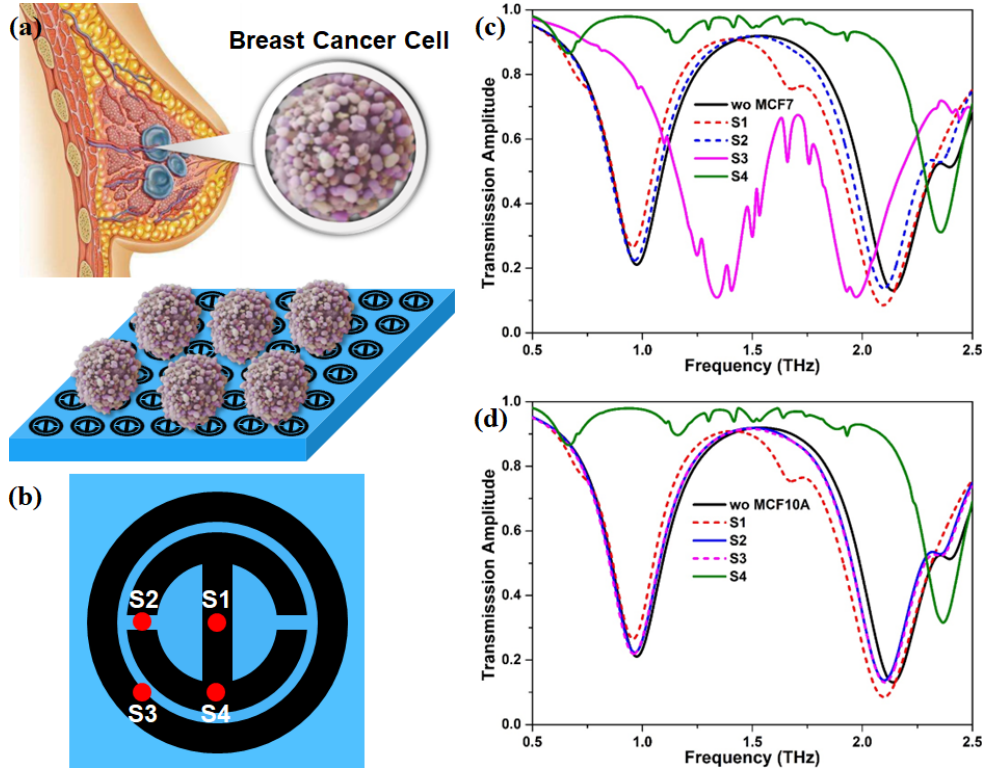
Figure 5. ( a ) The schematic diagram of the breast cancer cell and their sensing process. ( b ) The possible sites of MCF10A and MCF7 on the graphene metasurface. ( c , d ) The transmission spectra of single MCF7 and MCF10A on different sites in panel ( b